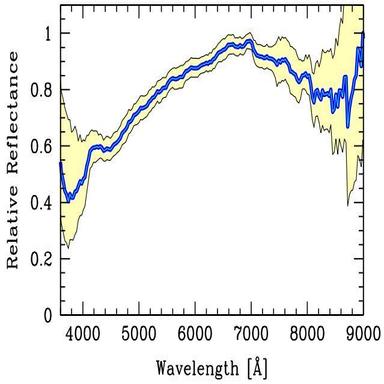
The WT1190F relative reflectance computed by dividing the observed flux of by the synthetic solar spectrum. The resulting ratio was finally normalized to a unity peak. For its sharply reduced response about 4000 A and a shallower dip, about 8500 A, the curve may be suggestive of a prevailing presence of Aluminum in the surface texture of the object.